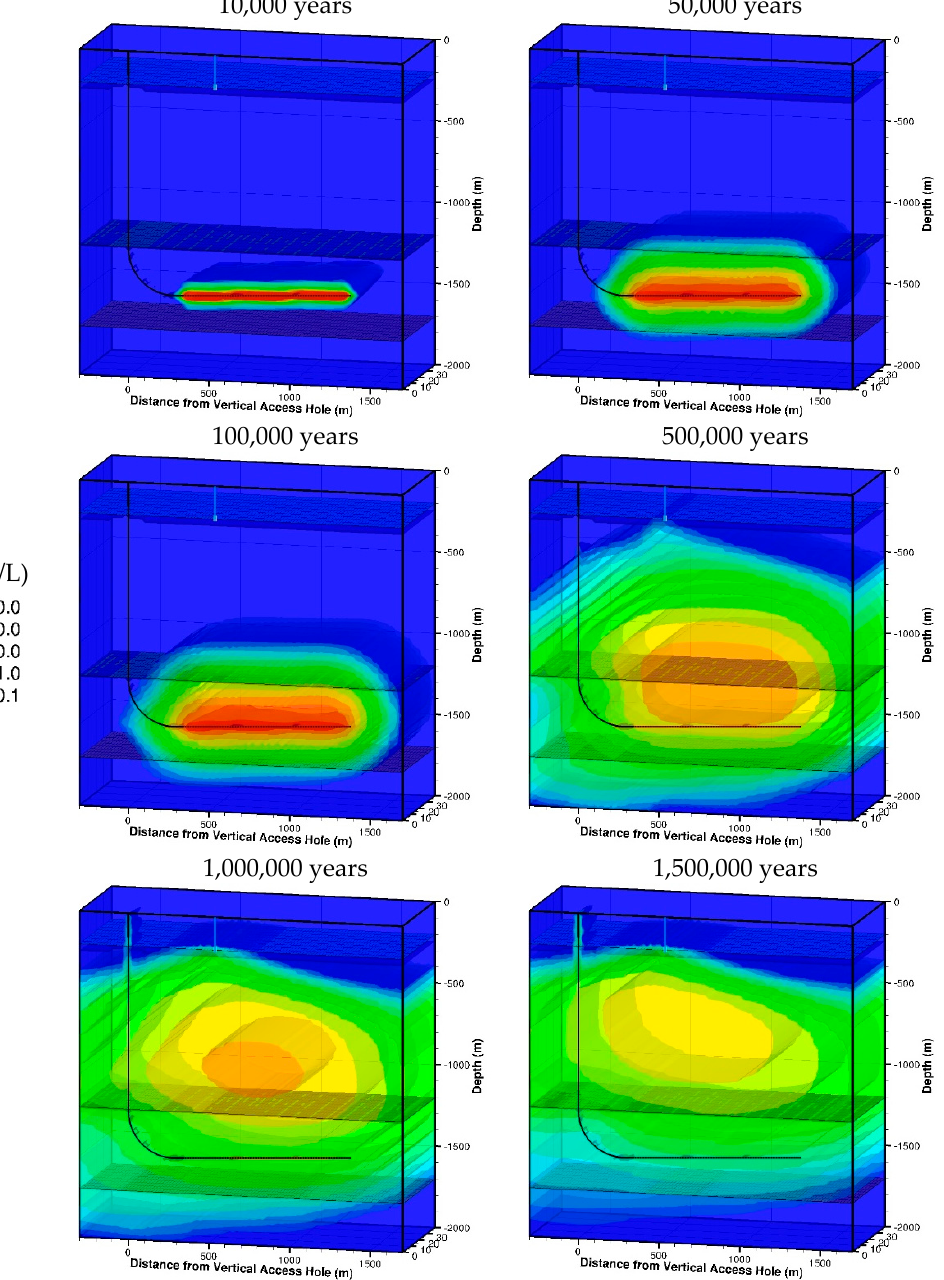
Figure 5. Distribution of 129 I activity at different times for reference scenario. The drinking-water well is indicated by the narrow vertical line that extends from the surface to 200 m depth.